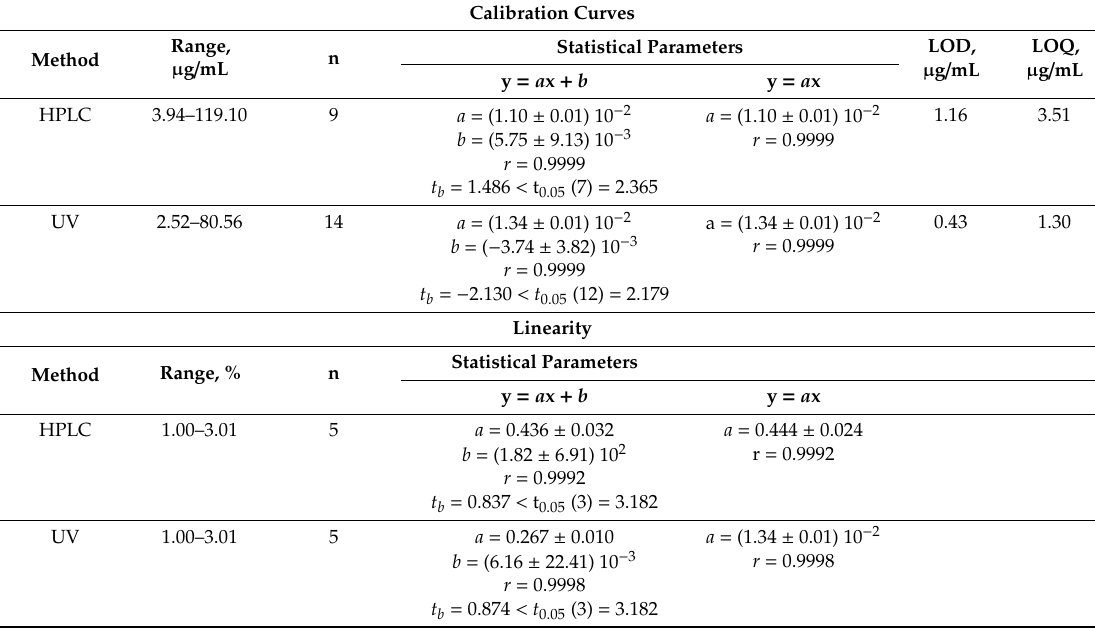
Table 3. The quantitative parameters and statistical data for determination of CS by the proposed HPLC and UV method—validation parameters: calibration curves and linearity.